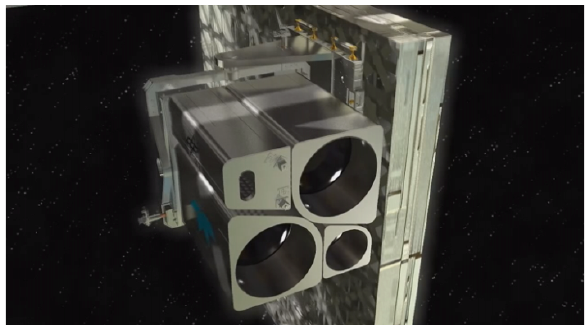
Figure 1. View of the MUSES platform equipped with four instruments (© Teledyne Brown Engineering. All rights